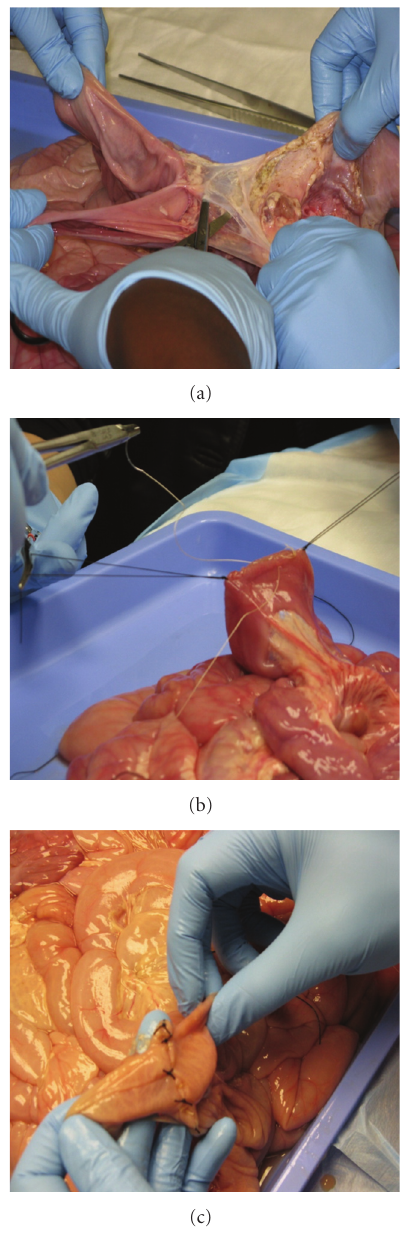
Figure 1: Bowel Surgery using ex-vivo Porcine Bowel Model. (a) Lysis of adhesions; (b) Enterotomy repair; (c) Bowel resection and